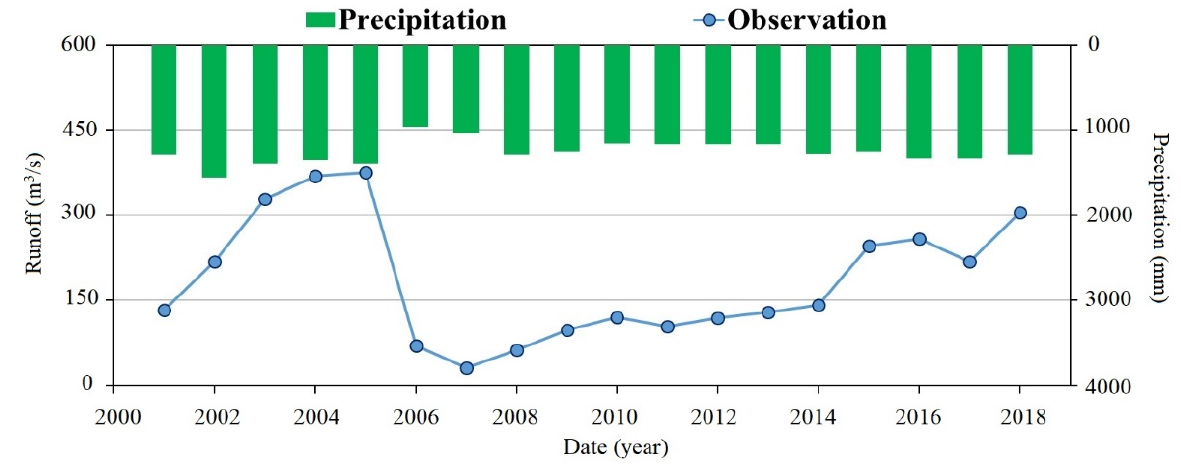
Figure 7. Annual runoff and precipitation at the outlet site from 2001 to 2018.